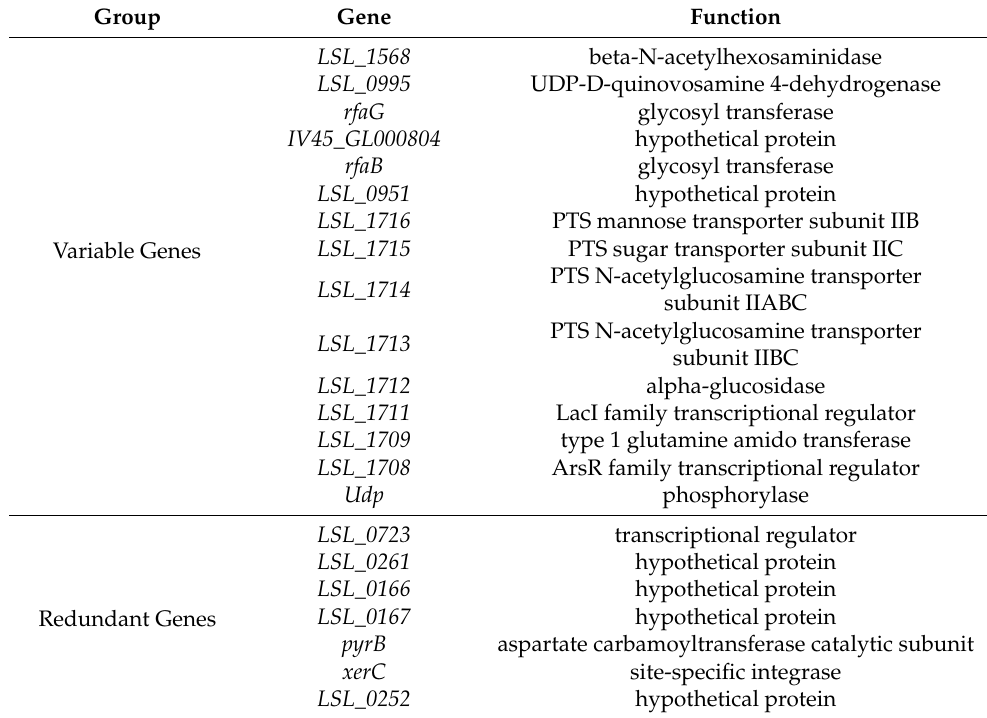
Table 2. Functions of the different genes identified between the two groups of L. salivarius